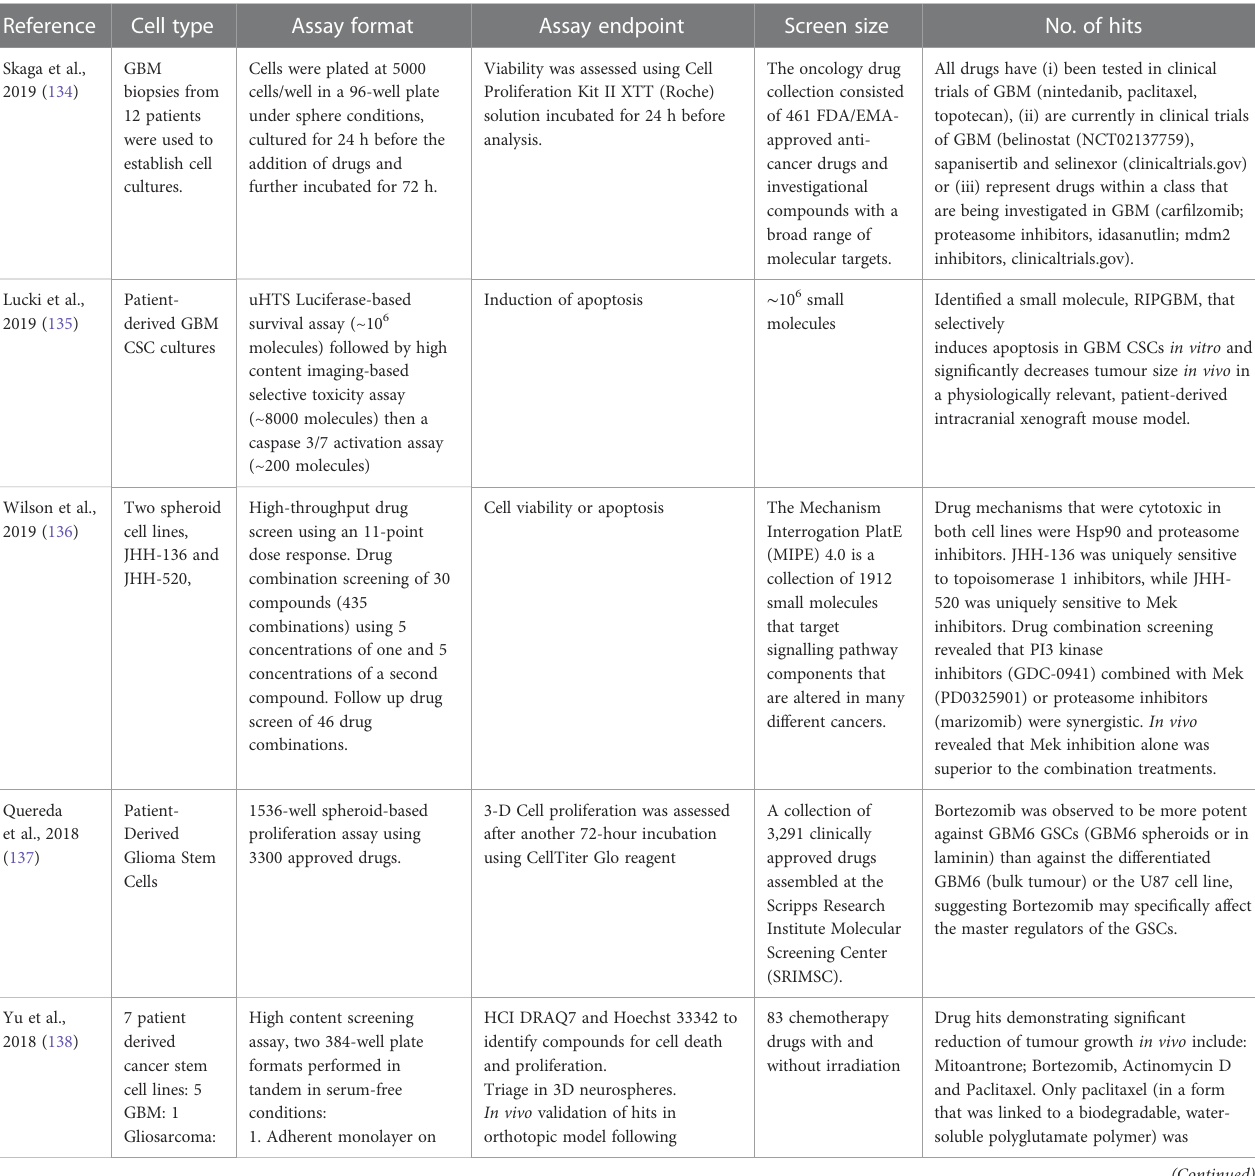
TABLE 3 Non-hypothesis driven HTS campaigns to identify novel targets, drug-combinations or small compounds for the treatment of GBM.